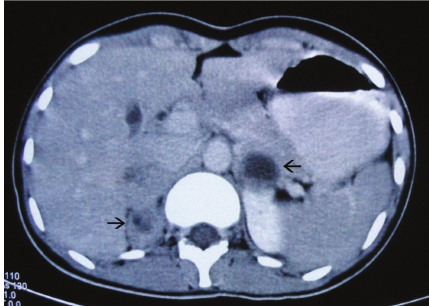
Figure 2: Axial ultrasound images taken just above the level of thyroid isthmus showing a well-defined, heterogeneous, predom- inantly hypoechoic round lesion in the right lobe of thyroid. Small echogenicities within the lesion were noted suggestive of microcalcification (black arrows). Another larger heterogeneous solid lesion is seen in the left lobe of thyroid.